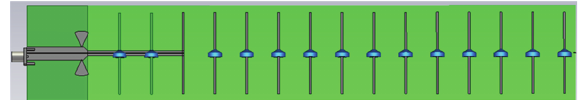
Figure 30: The active dipole is fed through a coplanar waveguide. A balun achieves both the matching impedance and the symmetri- sation of the currents into the coplanar waveguide. Blue parts correspond to the lumped